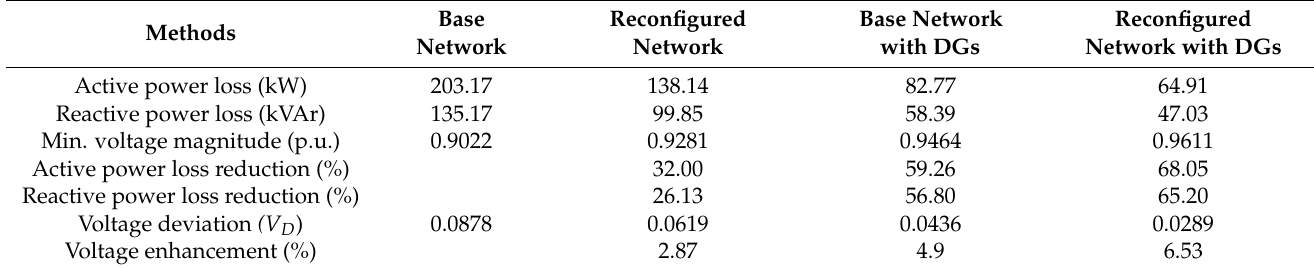
Table 2. Performance of proposed method on IEEE-33 bus radial distribution network.